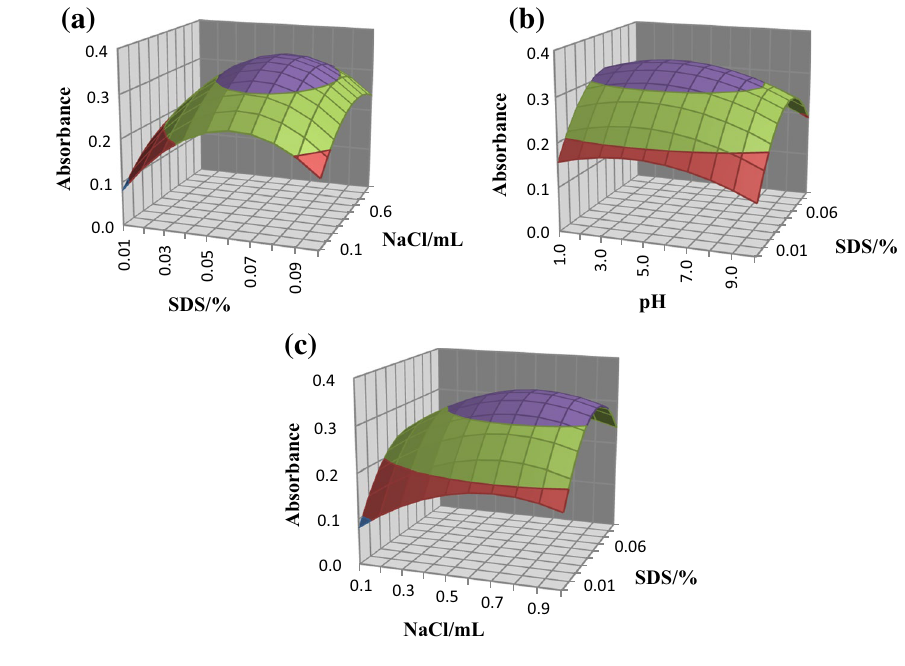
Table 4 Optimum conditions obtained by response surface methodol-